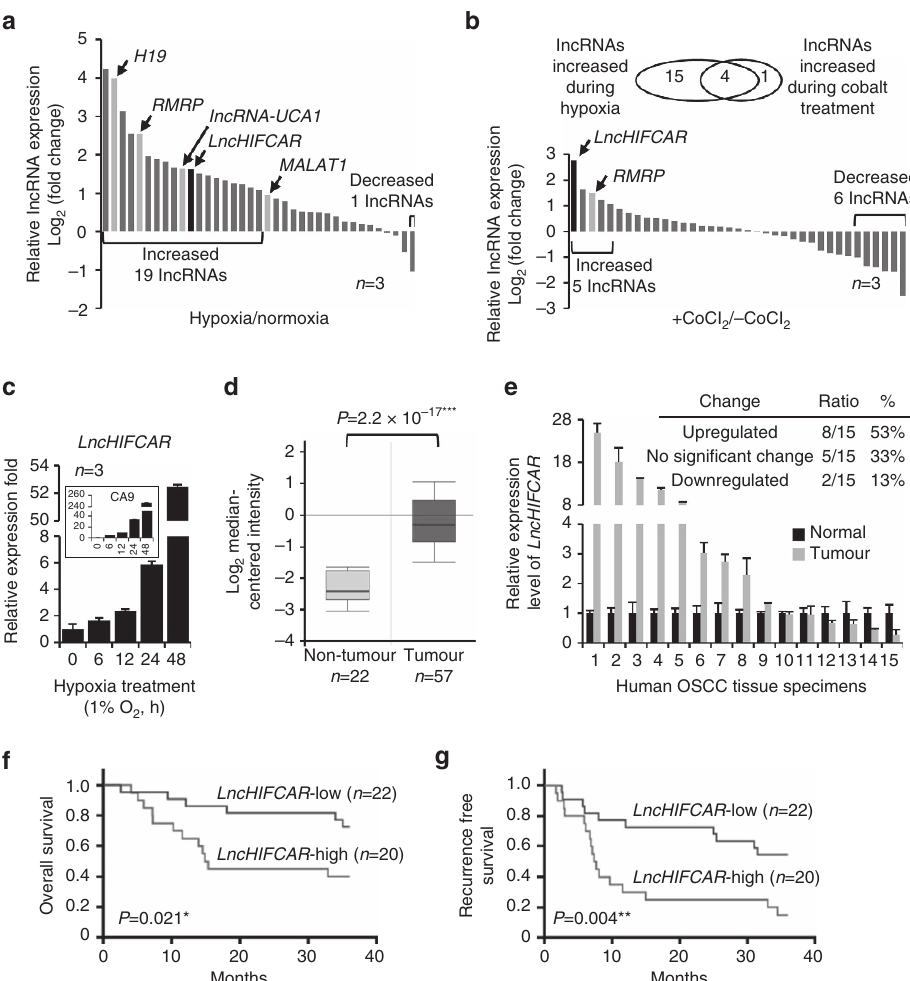
Figure 1 | LncHIFCAR expression is induced upon hypoxia and highly upregulated in human oral carcinoma with prognostic value. ( a , b ) The expression profiling of 37 cancer-associated lncRNAs in HeLa cells under hypoxia (1% O 2 for 16h; a ) or treated with hypoxia-mimetic agent cobalt chloride (100 m M for 16h; b ) was assessed by quantitative real-time PCR and normalized against 18S rRNA. Each bar represents the relative expression of each lncRNA after treatment. The Venn diagram shows the number of lncRNAs that were upregulated in response to hypoxia or cobalt chloride treatment. ( c ) Physical hypoxia induced the expression of LncHIFCAR in a time-dependent manner within 48h. HeLa cells were incubated in 1% oxygen for the indicated time period. Real-time PCR analyses determining the expression levels of LncHIFCAR and the intrinsic hypoxia marker CA9 mRNA were shown and normalized to 18S rRNA level. ( d ) LncHIFCAR expression in OSCC patient samples analysed in Peng Head-Neck data set (GEO: GSE25099) from Oncomine database. The LncHIFCAR expression is presented as box-plot diagrams, with the box encompassing 25th–75th percentile. Solid horizontal black line represents the median while error bars indicate the 10th to 90th percentile. Statistical analyses between different patient groups were examined by Student’s t -test, *** P o 0.001. ( e ) LncHIFCAR expression in 15 pairs of OSCC tissues (Tumour) and their normal counterpart tissues (Normal) was analysed by quantitative real-time PCR and normalized to RPLP0 . The LncHIFCAR expression showing a more than twofold change between normal and tumour samples was considered significant. ( f , g ) Kaplan–Meier curves of OS ( f ) and RFS ( g ). Patients were grouped into LncHIFCAR- Low or LncHIFCAR- High based on the LncHIFCAR expression value. The cutoff point is set as the value yielding maximum sum of sensitivity and specificity for RFS analysis. The P -values was determined by log-rank test, * P o 0.05 and ** P o 0.01. ( c , e ) Graphs show mean ± s.d. n , the number of independent